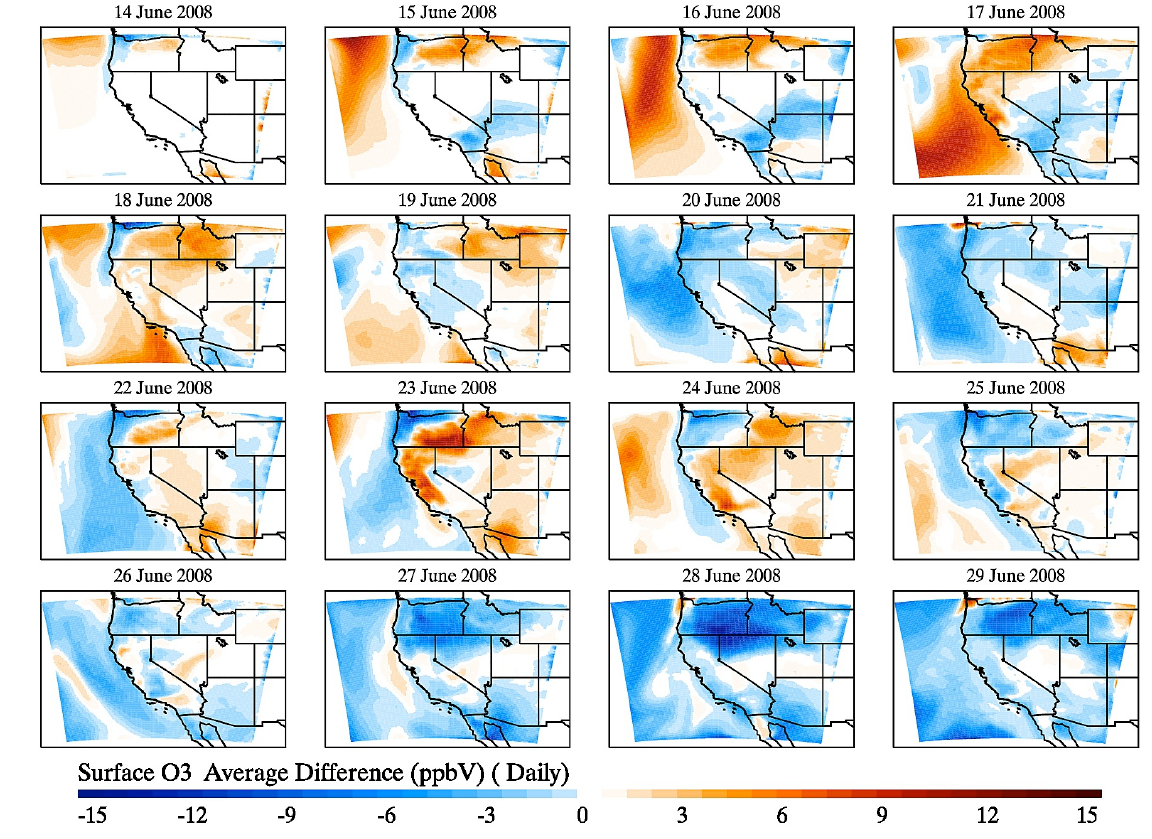
Fig. 10. Daily average difference in surface O 3 (ppbV) between the WRF-Chem simulations with temporally varying and with temporally averaged chemical boundary conditions (variable BC minus mean